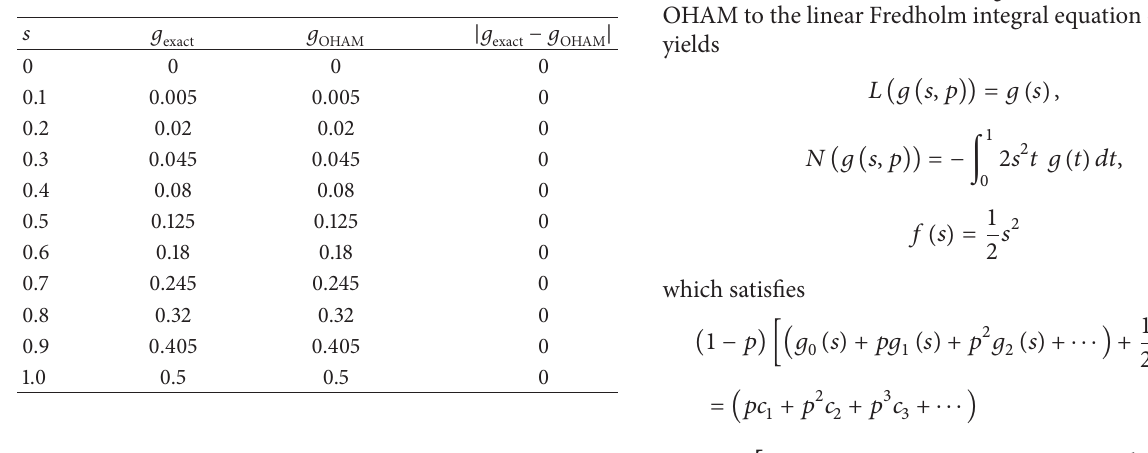
Table 2: Numerical results of Example